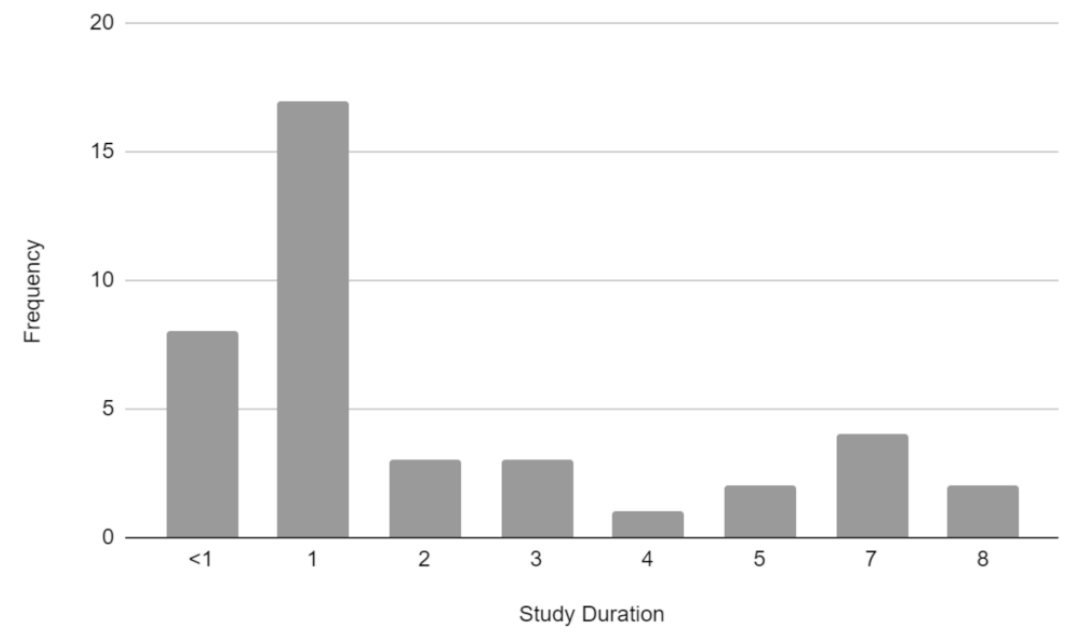
Figure 10. Frequency and duration of